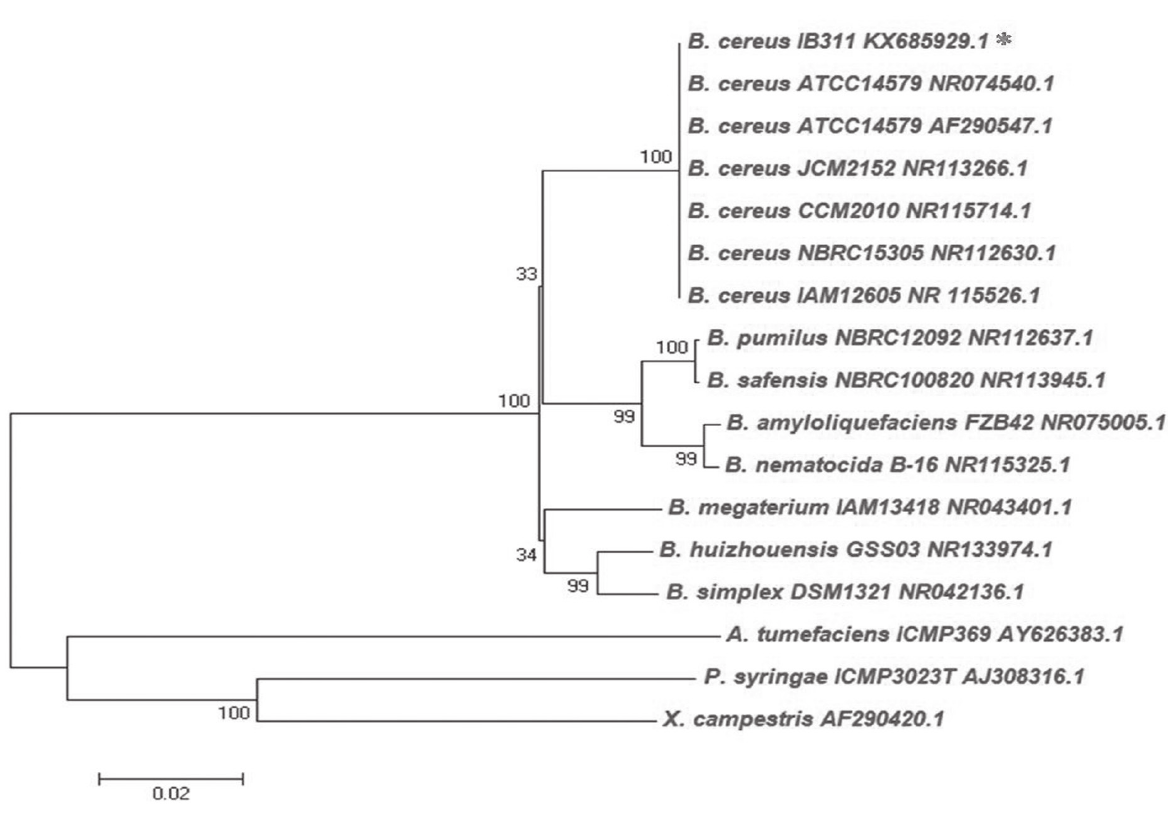
Figure 1 - Neighbour-joining tree based on partial 16S rRNA gene sequences showing relationships of Bacillus cereus strain IB311 (denoted with asterisks) with other close homologous strains. Three phytopathogenic bacteria (viz., Agrobacterium tumefaciens , Pseudomons syringae and Xanthomonas campestris ) were used as outgroups. Bootstrap values greater than 50% are highlighted at the nodes (100 replications). The scale bar represents 2 substitutions per 100 bases. Evolutionary analyses were conducted in MEGA